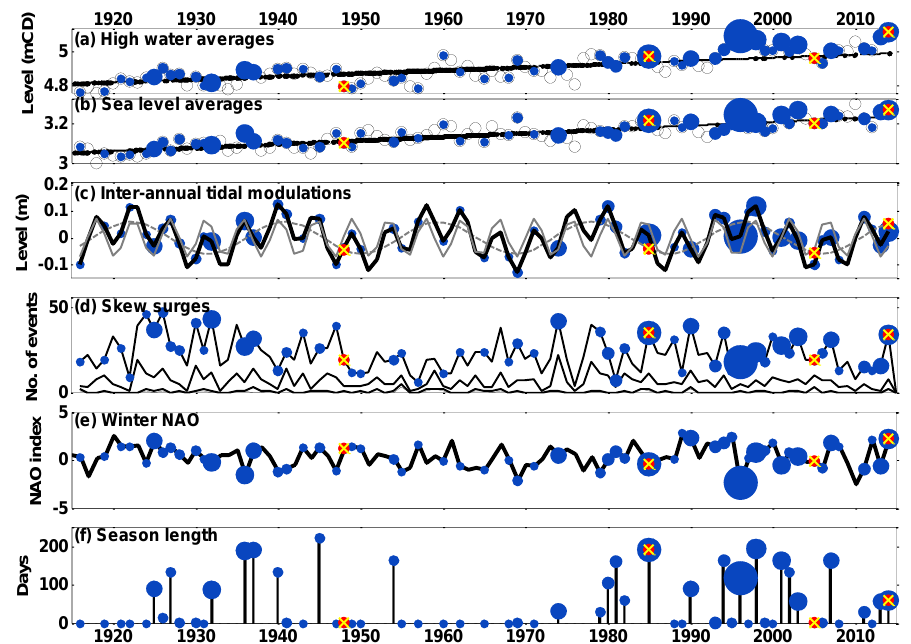
Figure 5. Blue dots (superimposed on each chart) represent the count of ≥ 1 in 1-year high waters in each July–July annual period (i.e. larger dots indicate larger clusters). The red-yellow markers highlight the four “big” one-off return period events (in 1948, 1985, 2004 and 2014). (a) Average height of high waters each season; (b) mean sea level in each season, with the linear trend; (c) Inter-annual tidal modulations: 4.4yr (solid grey), 18.6yr (dashed grey) and combined (solid black line); (d) seasonal count of skew surge events exceeding the thresholds averagely associated with ≥ 1 in 1, 5, 10 and 20-year high water (0.24, 0.34, 0.50 and 0.55m, respectively); (e) the winter North Atlantic oscillation (NAO) index, station-based, computed from the difference between normalised sea level pressure measurements from Gibraltar and Reykjavik, southwest Iceland; from the Climate Research Unit (CRU), University of East Anglia (http://www.cru.uea.ac.uk/cru/data/ nao.htm); (f) span of time (days) between the first and last ≥ 1 in 1-year events of each July–July season,